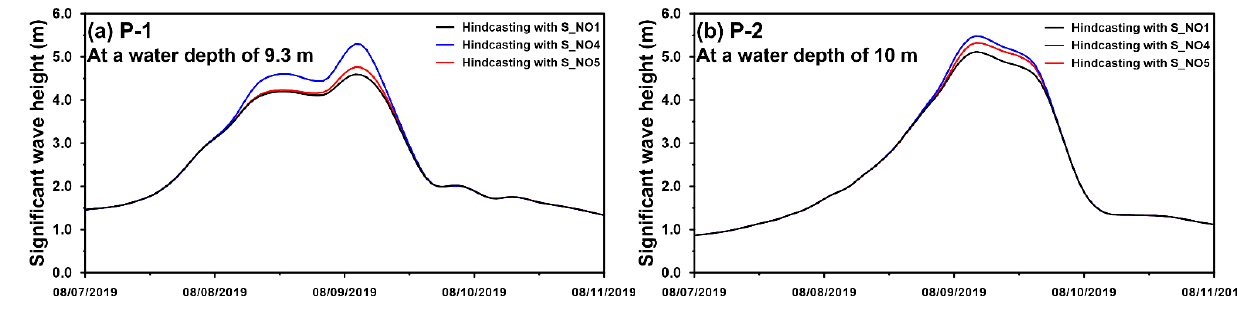
Figure 16. Time series of hindcasted SWHs for ( a ) P1 and ( b ) P2 using the S_NO1, S_NO4 and S_NO5 scenarios during the passage of Super Typhoon Lekima in 2019.